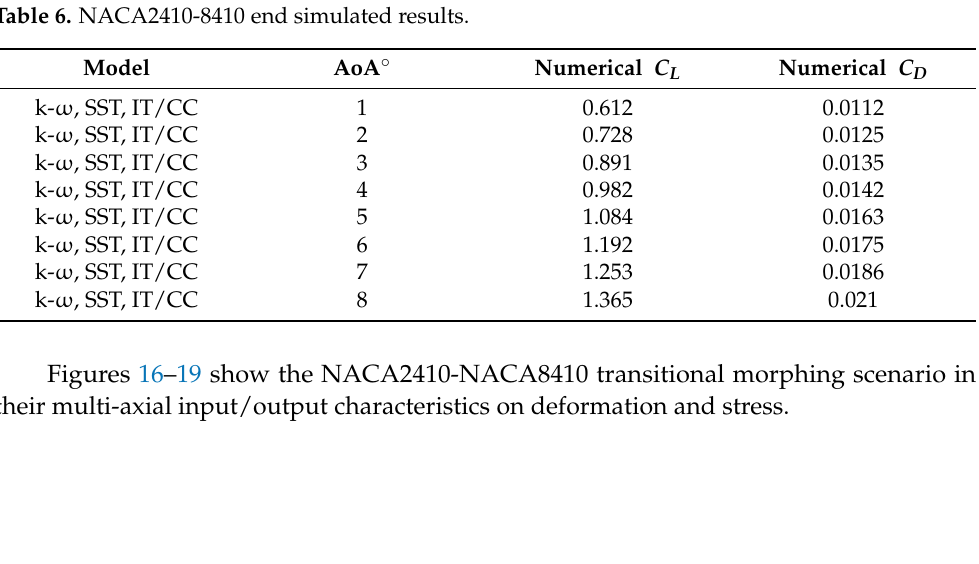
Figure 15. Pressure distribution of the NACA8410 with varying AoA while x ticks from 0 with in- crement of 0.32; (0, 0.32, 0.64, 0.96, 1.28, 1.6, and 1.92 respectively).